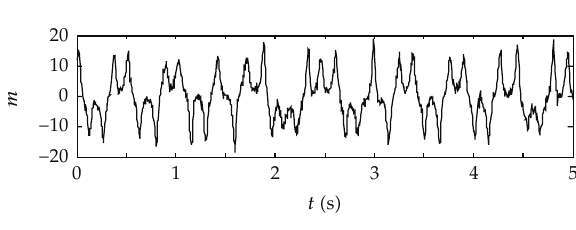
Figure 6: The mixed